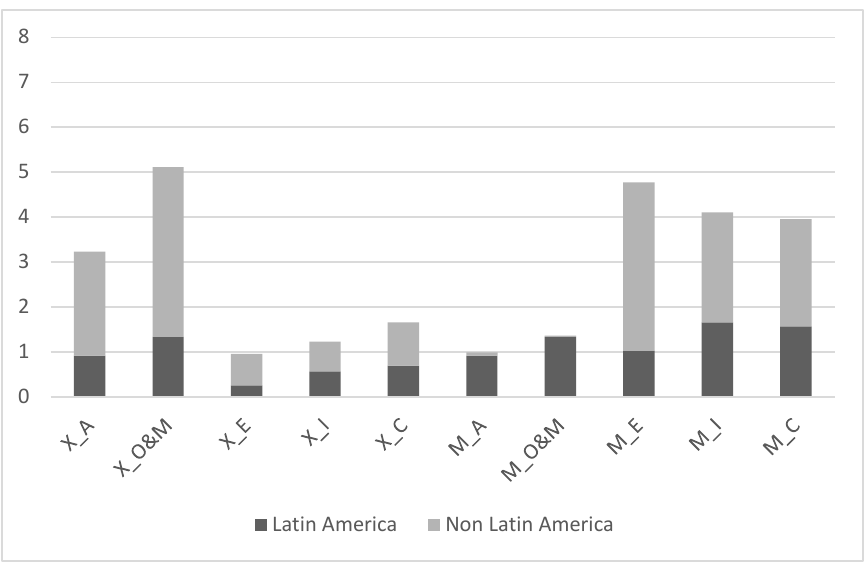
Figure 3 : Latin America: intra and extra-regional exports and imports by products (% of GDP), average